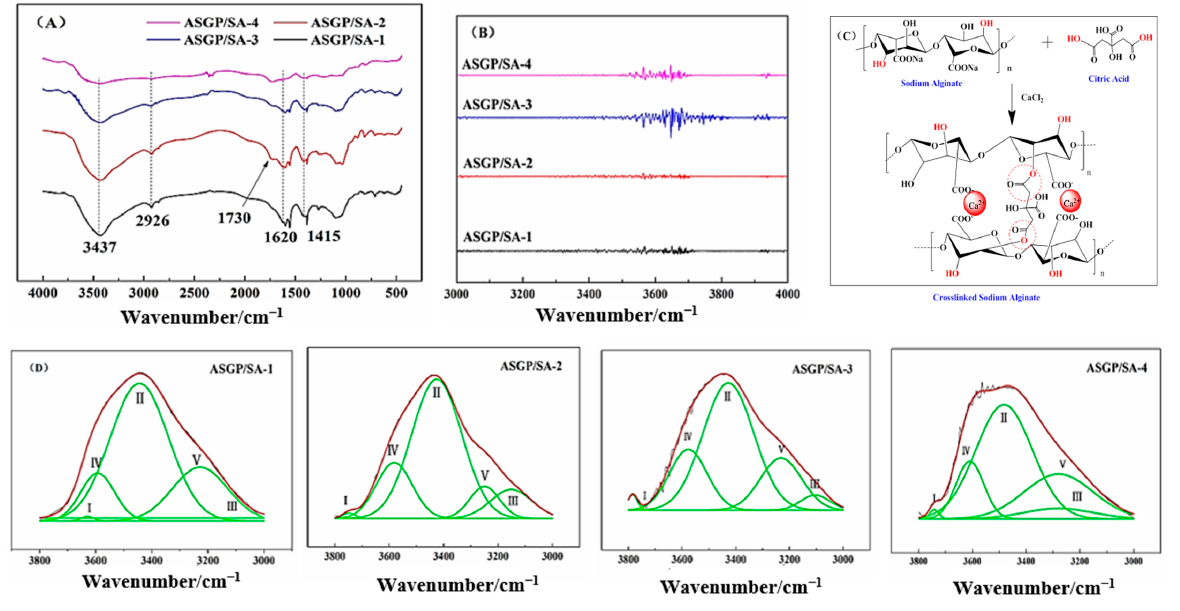
Figure 3. ( A ) FT-IR spectra, ( B ) the second derivative spectra, ( C ) solidifying mechanism, and ( D ) Gauss fitting curves of drug-loaded hydrogels. Table 2. Specific preparation parameters of hydrogels.